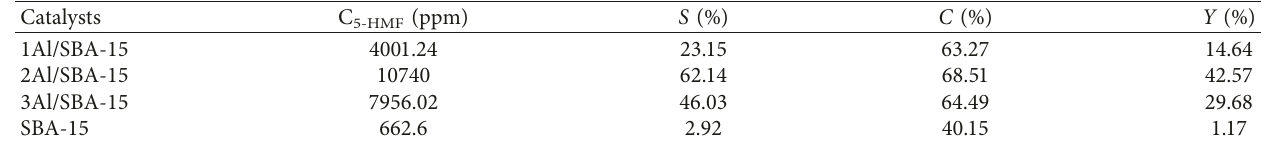
Table 5: Conversion and selectivity of 5-HMF over xAl/SBA-15 catalyst.